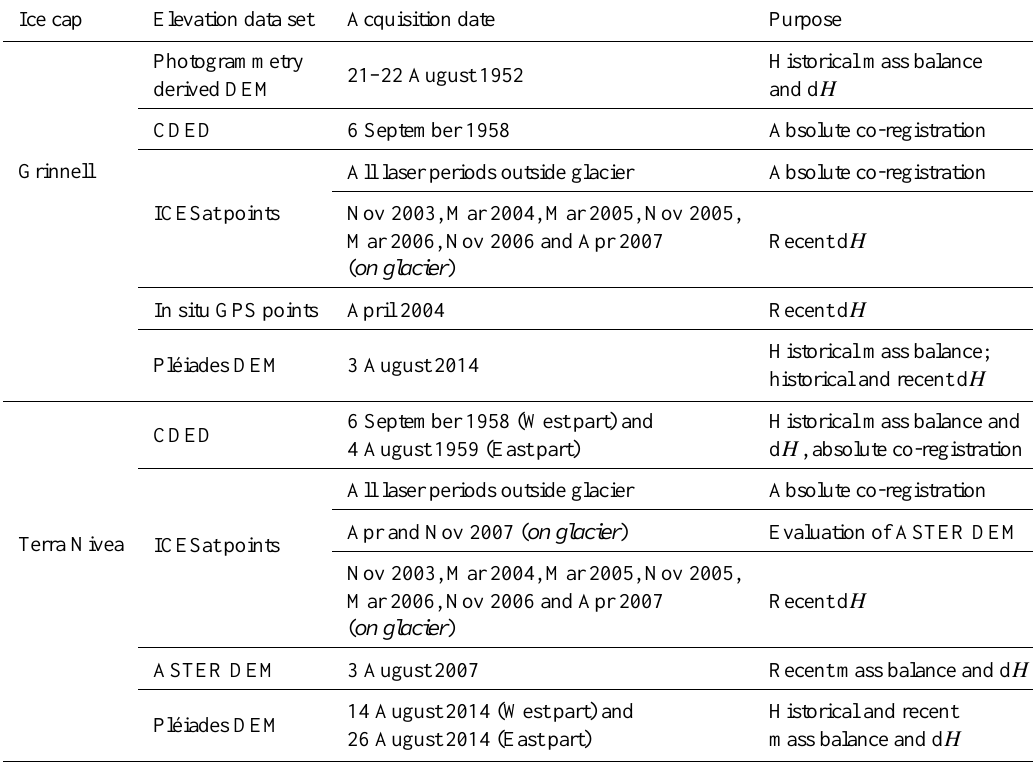
Table 1. Elevation data sets used in this study with the acquisition date and the purpose of their use for each ice cap. Ice